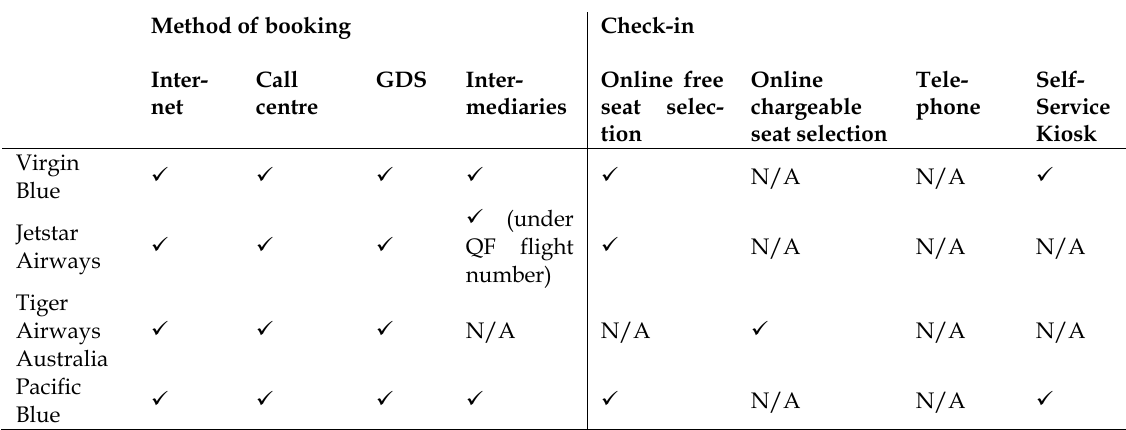
Table 10. Method of Booking/Check-in Services Method of